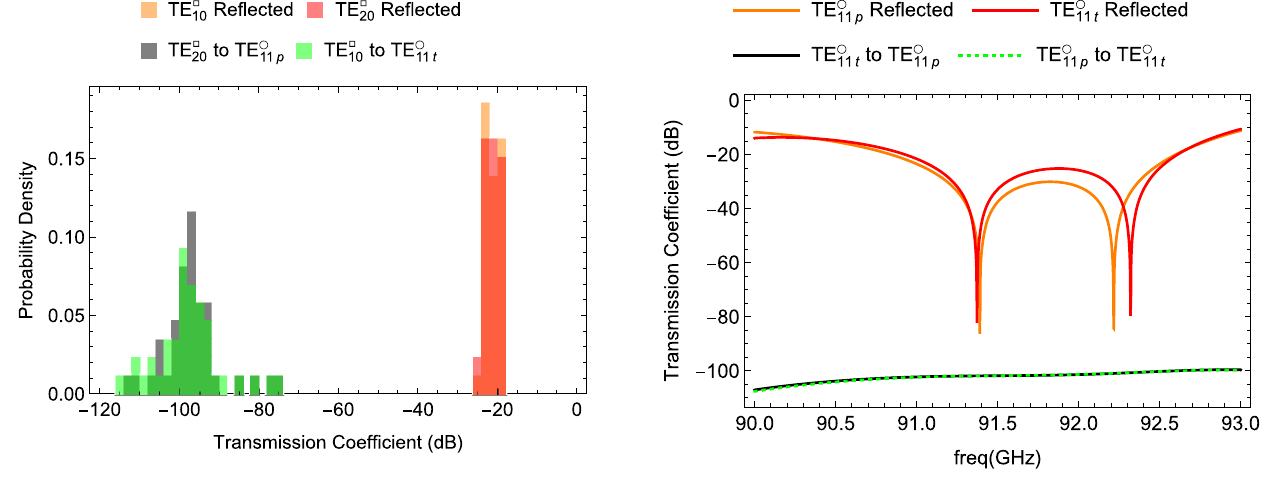
FIG. 25. Cylindrical TE ○ 11 to rectangular TE □ 10 = TE □ 20 mode converter with chokes s-parameters tolerances, obtained by varying 11 geometrical parameters uniformly (cid:2) 5 μ m.